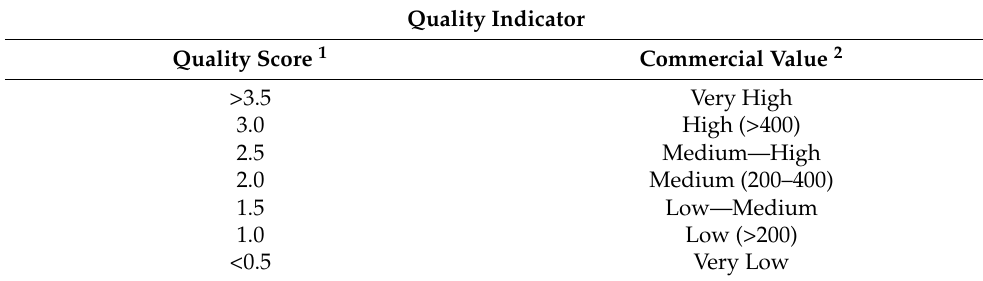
Table 1. The Quality Index (QI) Tool. The quality equation for each quality marker is used to determine quality indicators for green